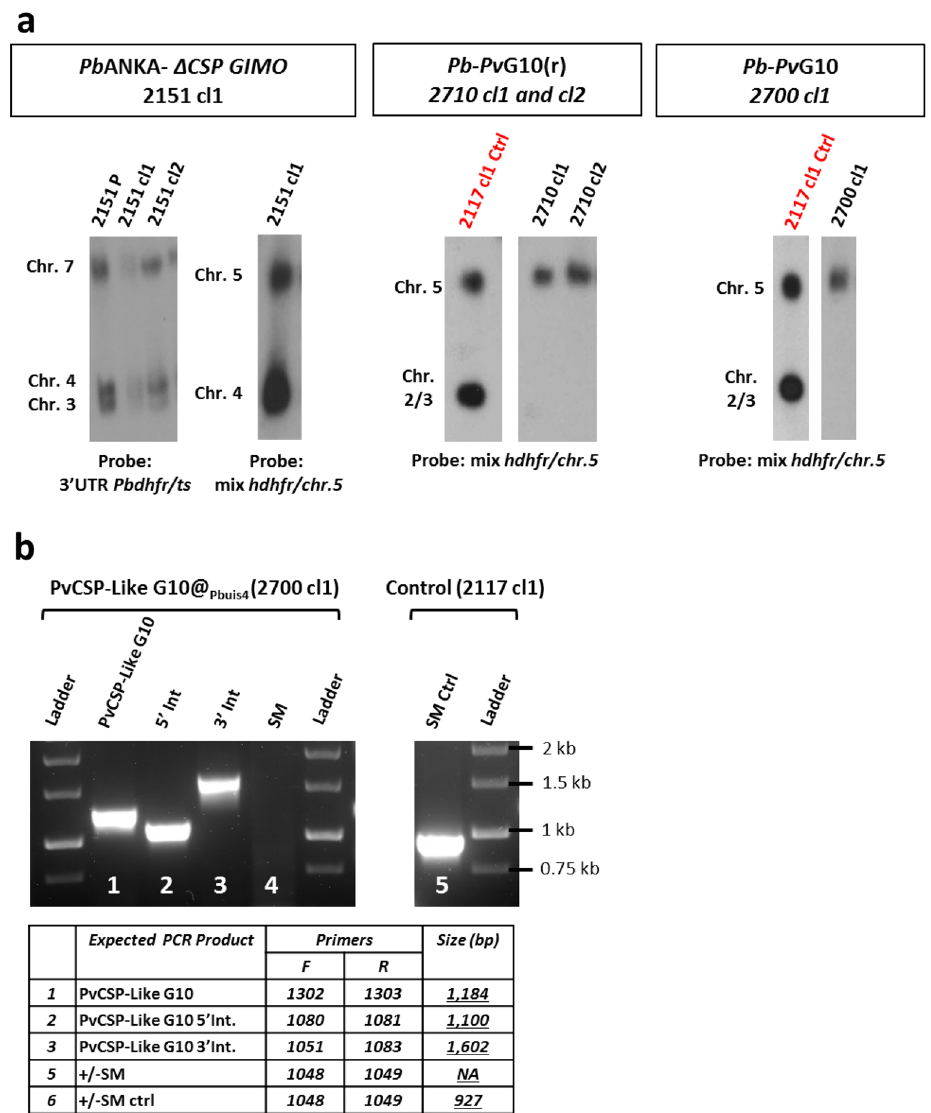
Figure 4. Genotyping analyses of chimeric P. berghei parasite lines expressing the Pv CSP- P. vivax -like protein. Cropped gels and blots are displayed in this figure. Full-length blots/gels are presented in Supplementary Fig. 4. ( a ) Genotyping analysis of the replacement line Pb-Pv G10(r) (2710cl1 and cl2) and its intermediate GIMO mother-line (2151cl1) using a Southern analysis of chromosomes (chr.) separated by pulsed-field gel electrophoresis (PFGE) and diagnostic PCR analysis. Left panel: Hybridization of chr. from line 2151cl1 with the 3 ′ UTR Pbdhfr/ts confirms integration of construct pL1929 into the Pbcsp gene on chr. 4. In addition, this probe hybridizes to the GFP-Luc reporter cassette on chr. 3 and to the endogenous Pbdhfr/ts on chr. 7. The correct integration of the SM is also confirmed by using a mixture of two probes: one recognizing hdhfr and a control probe recognizing chr. 5. Middle panel: The correct integration of the Pv CSP- P. vivax -like gene expression construct (pL2161) into the GIMO locus was confirmed by showing the removal of the h dhfr:: y fcu selectable marker (SM) cassette in clones of the chimeric parasite line Pb-Pv G10(r) (2710cl1 and 2710cl2). The Southern blot was hybridized with a mixture of two probes: one recognizing h dhfr and a control probe recognizing chr. 5. As an additional control (ctrl), parasite line 2117cl1 was used with the h dhfr:: y fcu SM integrated into chr. 3. Right panel: Southern analysis of chr. of the ‘additional copy’ chimeric line Pb-Pv G10(r) (2700cl1) confirms the correct integration of the expression PvCSP-Like G10@Pbuis4 construct (pL2163) into the GIMO locus ( 230p on chr. 3), shown as the removal of the h dhfr:: y fcu SM cassette in cloned chimeric parasites compared to a control probe recognizing chr. 5. As an additional control (Ctrl), parasite line 2117cl1 is also shown, as it retains h dhfr:: y fcu SM in the 230p locus on chr. 3. ( b ) Genotyping using a diagnostic PCR analysis of the chimeric Pb-Pv CSP-like G10 line (2700cl1; left panel) confirms correct integration of the PvCSP-Like@Pbuis4 expression cassette. Correct integration is shown by the absence of the h dhfr ::y fcu SM and the presence of the Pv CSP- P. vivax -like CDS and the correct integration of the construct into the genome at both the 5 ′ and 3 ′ regions (5 ′ int and 3 ′ int; see Fig. 3 for primer locations). The primer sequences used in this study are shown in Table S1, while the expected PCR product sizes and the primer numbers are listed in the table below the PCR analysis. As an additional control (ctrl), parasite line 2117cl1 (right panel) was used to validate the primers used to amplify the h dhfr:: y fcu SM that was integrated into chr. 3 but has been removed from